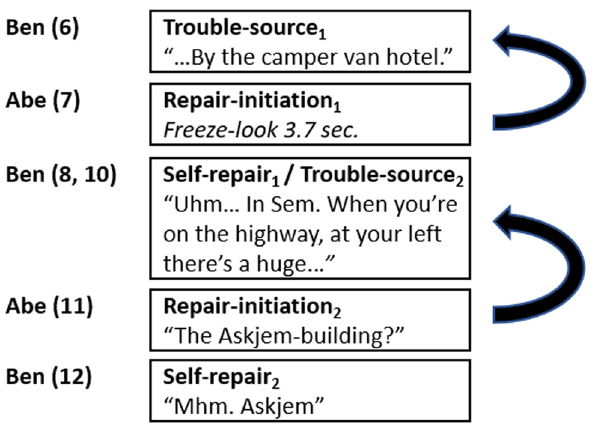
Figure 14: Multiple OIR sequences where a self - repair becomes a new trouble